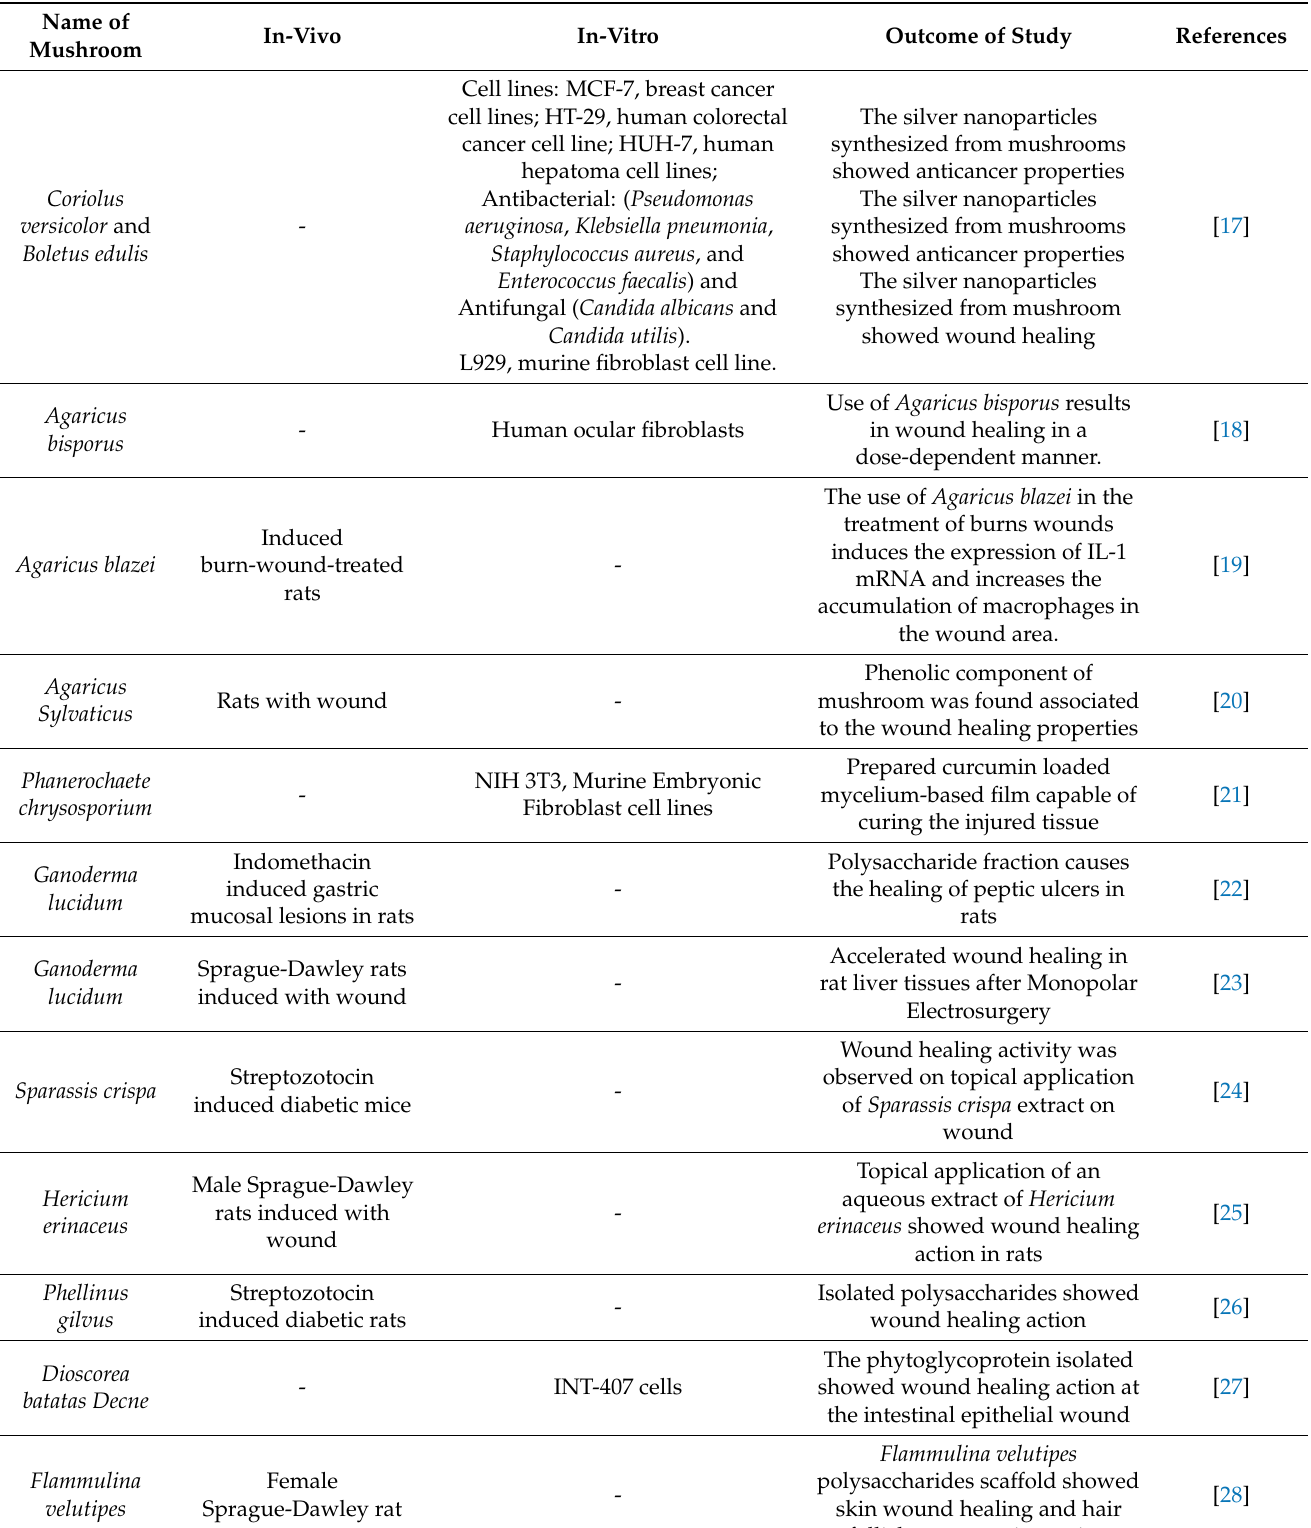
Table 1. Medicinal mushrooms have wound-healing